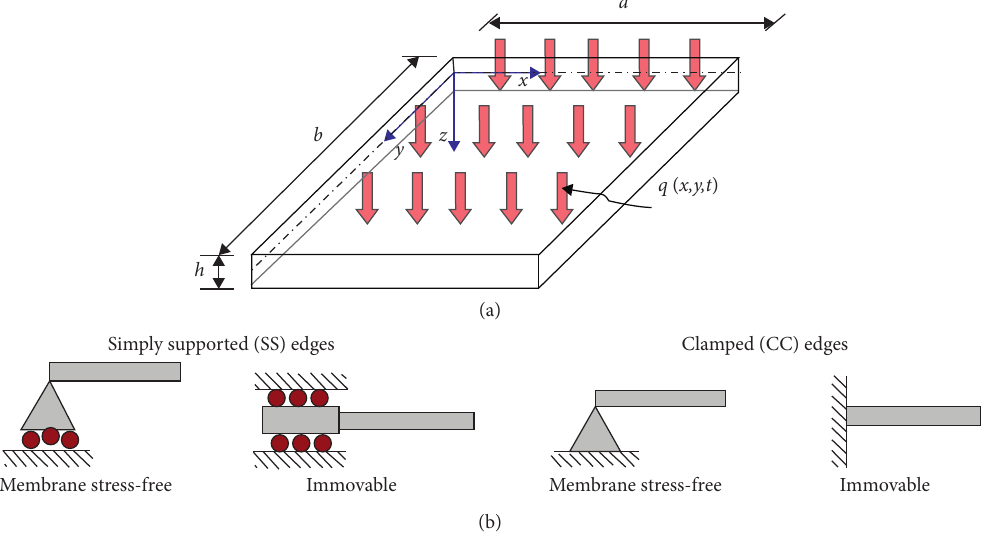
Figure 2: (a) Reference thin elastic plate under uniform pressure ( q ), with evidence of (b) the selected edge boundary